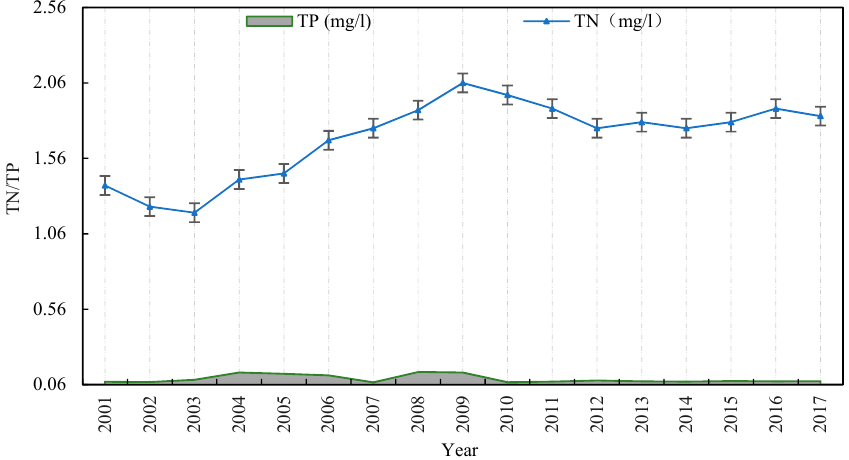
0.060.561.061.562.06 Figure 15. Total nitrogen (TN) and total phosphorus (TP) in the lake during Figure 15. Total nitrogen (TN) and total phosphorus (TP) in the lake during 2001–2017. Figure 16. PCA ordination diagram of interannual algal blooms in Dongting Lake. ( a ) 2001–2003; ( b ) 2003–2008; ( c ) 2008–2013; and ( d ) 2013–2017. (The bloom ratio is the ratio of the annual mean algal bloom area to the water surface area in the same year). 4.2. Environmental Drivers of Monthly Water Body and Algal Bloom Dynamics The average monthly water surface area of Dongting Lake from 2001 to 2017 coincided well with the rainfall pattern in different seasons. According to Figure 17, large water surface area